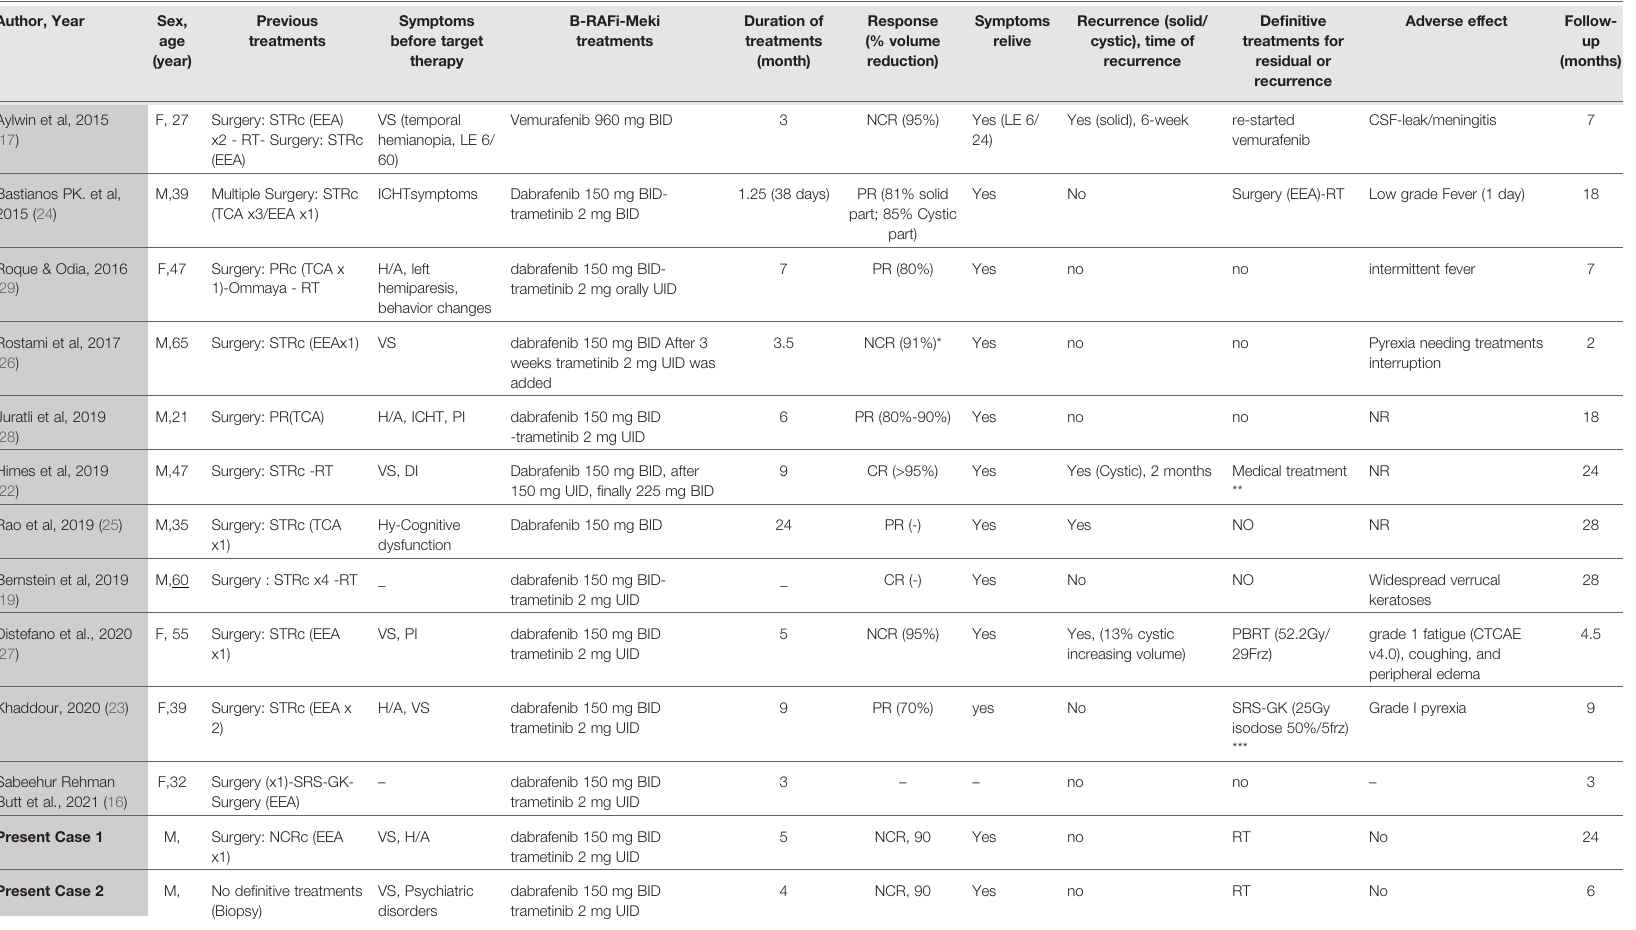
TABLE 1 | Literary review of all PCPs reported case treated with BRAF/MEK inhibitor agents. Author,